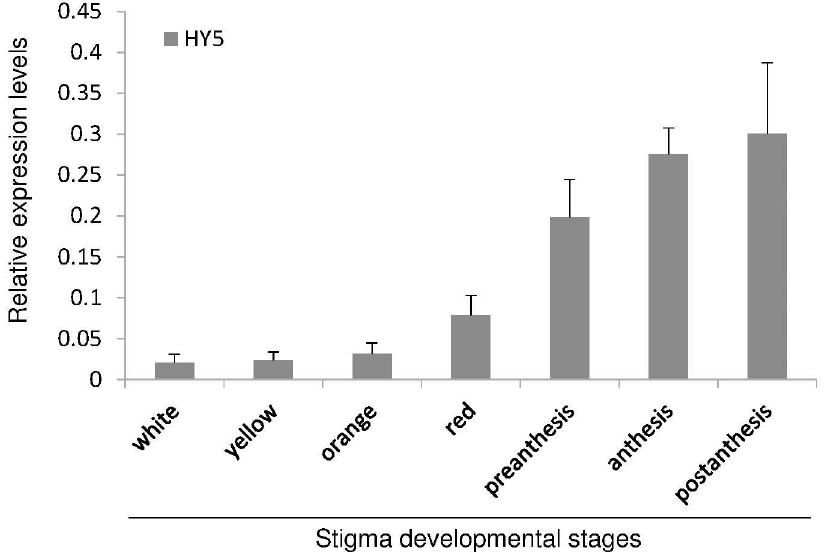
Fig 6. Relative expressionlevels of HY5 along the development of the stigma in saffron. Developmental stages are the same as the ones representedin Fig 3A. Error bars depict